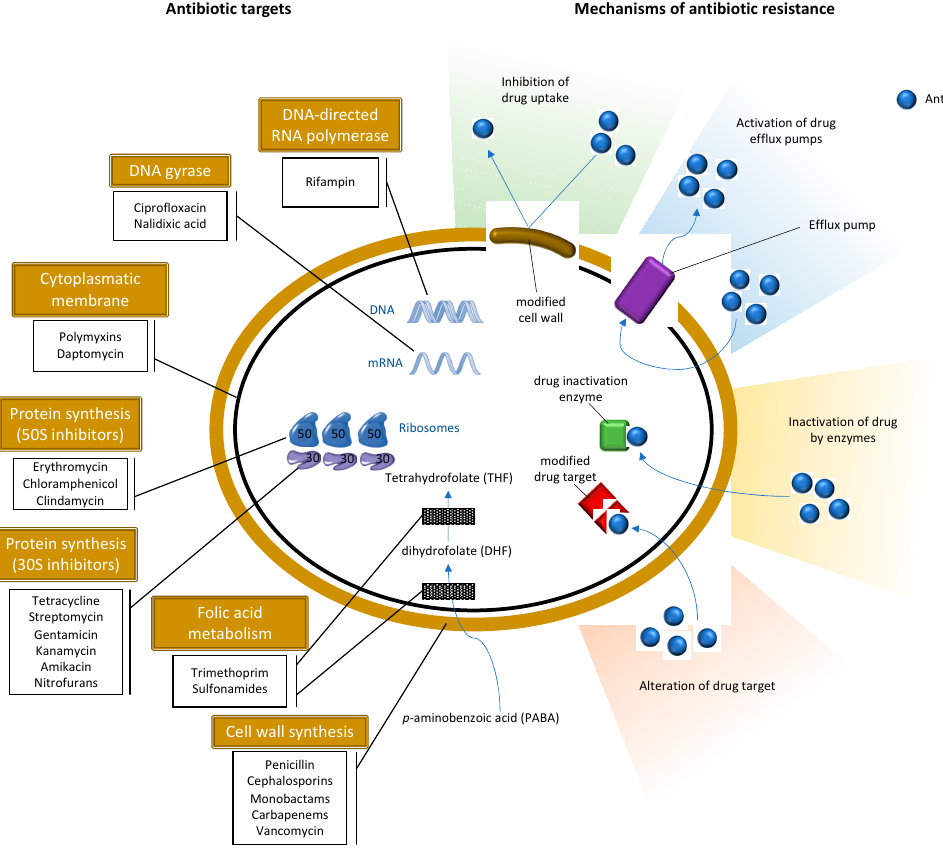
Figure 2. Schematic representation of antibiotic targets and mechanisms of antimicrobial resistance in S. aureus